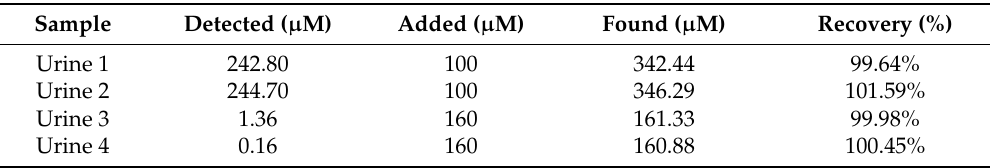
Table 2. Analysis data of uric acid in real samples ( n =